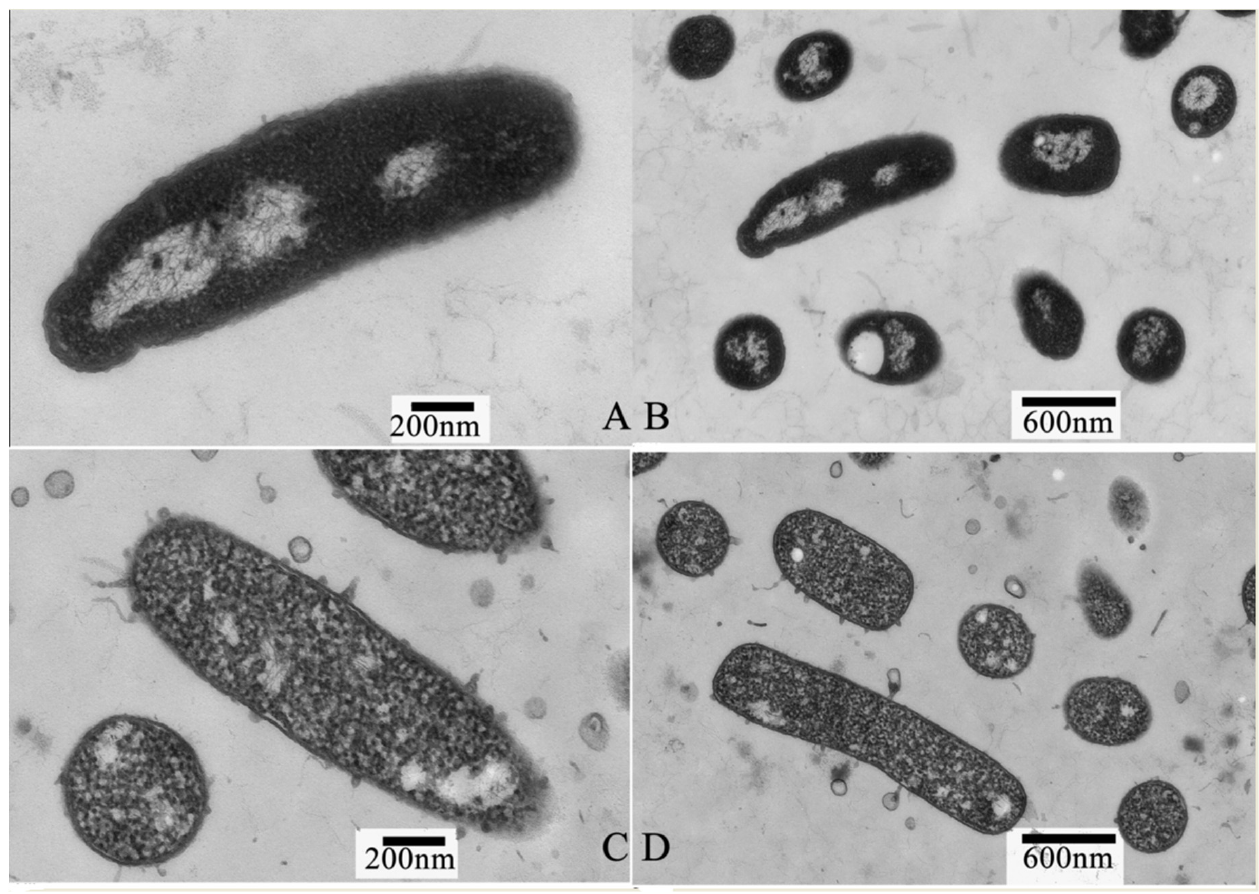
Figure 4. Transmission electron micrographs of P. lundensis cells treated with DIW ( A , B ) and cells treated with PALA (0.20%) ( C , D ). The scale bars of 4 ( A ) and 4 ( C ) are 200 µ m, the scan bars of 2 ( A ) and 2 ( C ) are 200 nm and 2 ( B ) and 2 ( D ) are 600